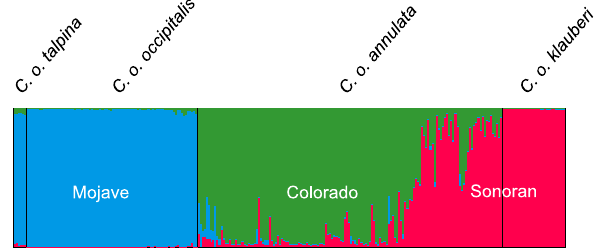
Figure 3. Assignment probabilities based on the STRUCTURE analysis ( K = 3). a) Each individual is represented by a single column with membership assignment probabilities for each of the three clusters ( K ) noted as the relative proportion of each color (blue, green, and red represent the Mojave, Colorado, and Sonoran clusters, respectively). The vertical black bars represent the a priori subspecies assignment for each individual that was used in the analysis.